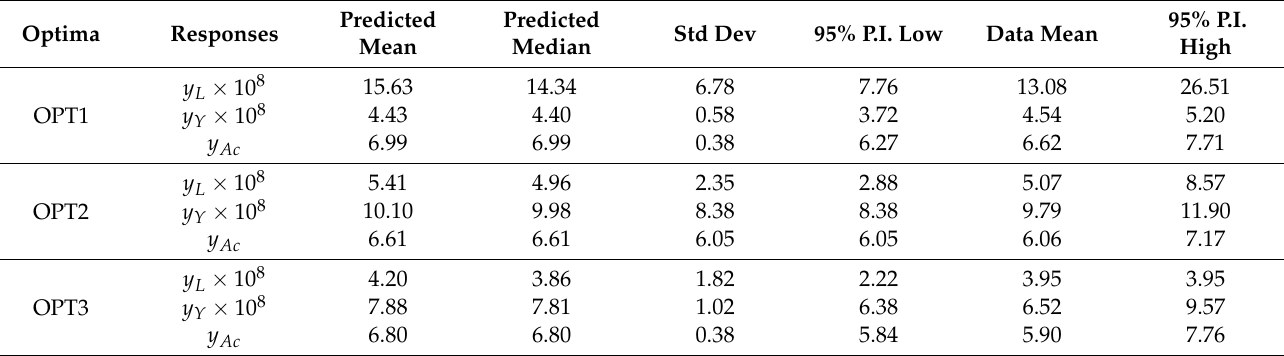
Table 4. Five confirmatory experiments of the models (Equations (1)–(3)) for each optimum. Re- sponses under optimal values compositions of factors A-D of mixes 1 and 2 fall within the acceptable values ranges ( p <